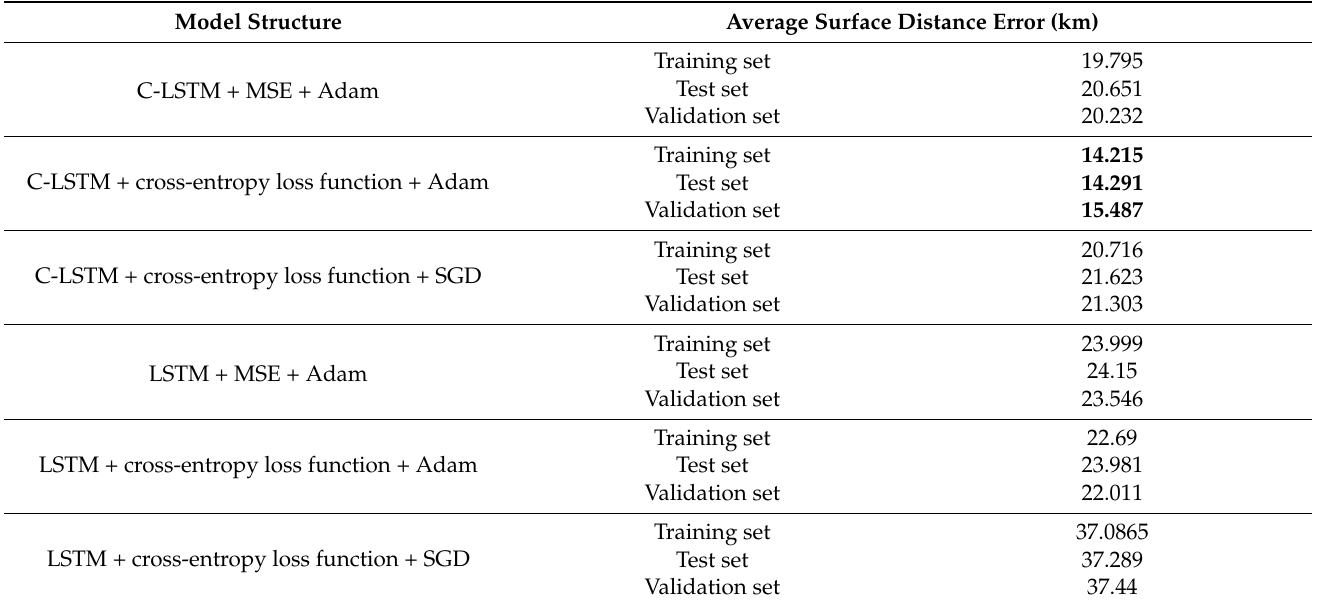
Table 5. Average surface distance error between predicted and real paths with different parameters of the C-LSTM model and LSTM model (unit: